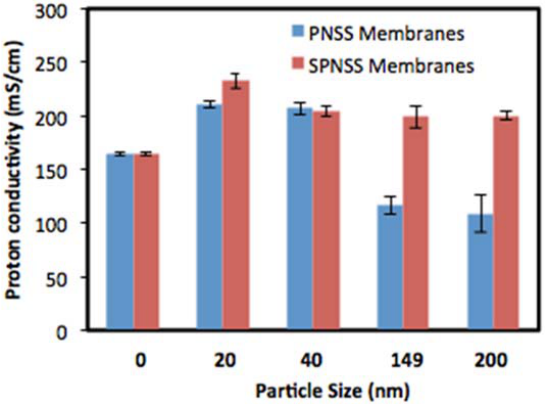
Figure 8. Comparison of proton conductivity of PNSS and SPNSS nanocomposite membranes at 120°C and 100% relative humidity.